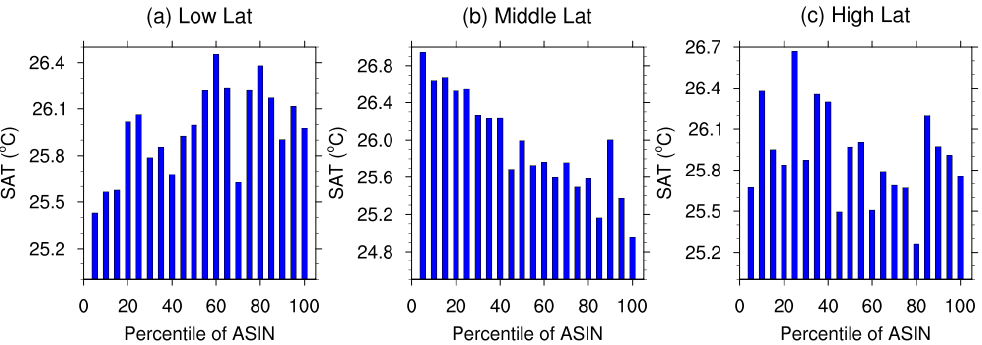
Figure 4. The influence of ASIN at different latitudes—( a ) low latitude (5850–5900 m), ( b ) middle latitude (5750–5800 m), ( c ) high latitude (5400–5450 m)—on the SAT (°C) in southeastern China.